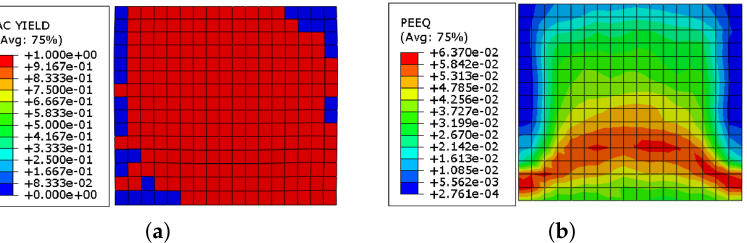
Figure 14. ( a ) AC yield distribution in the URM wall; ( b ) equivalent plastic strain (˜ ε pl c ) distribution in the URM wall.